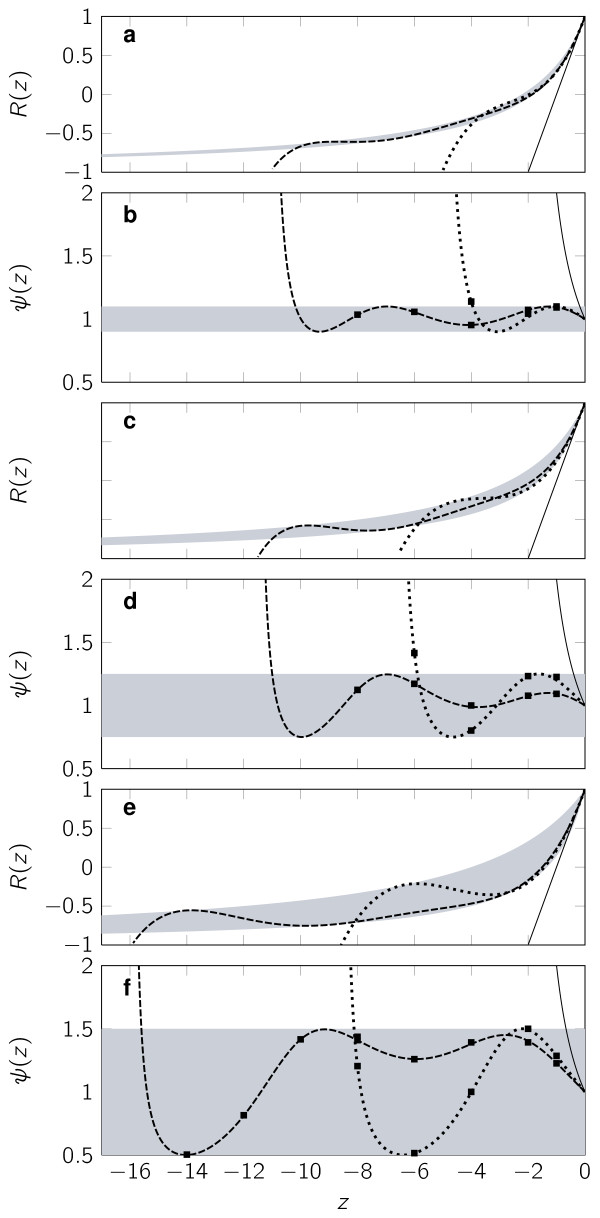
Stability and relative variance for the different methods. Stability and relative variance functions for the Poisson τ-leap method (solid line) and RK τ-leap methods with optimal stability regions and bounded relative variance (ψ) with 3 stages (dotted line) and 5 stages (dashed line). Regions fulfilling the bounds on ψ are shown in grey. Square dots correspond to relative variances computed from 106 simulations each. (a), (b): Relative variance bounded by 0.1. (c), (d): Relative variance bounded by 0.25. (e), (f): Relative variance bounded by 0.5.